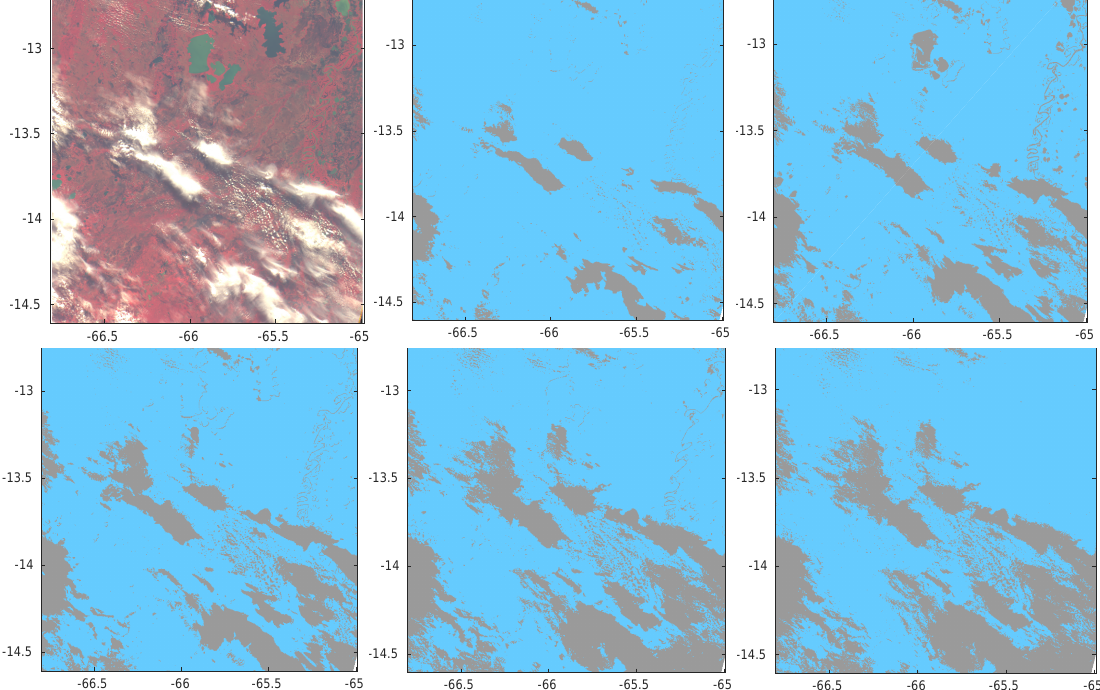
Figure 5. RGB image acquired on 21 June 2014 at 14:42 UTC over Bolivia (top-left panel). Other panels show cloud masks obtained by LDA, PCDA, CDA, ANN and KNN (orderly from left to right and from top to bottom). Classification was made separately for each type of